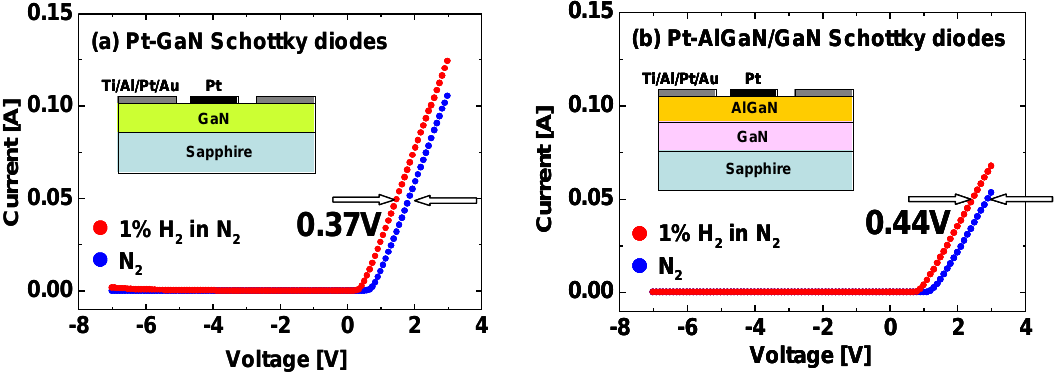
in N at room 2 2